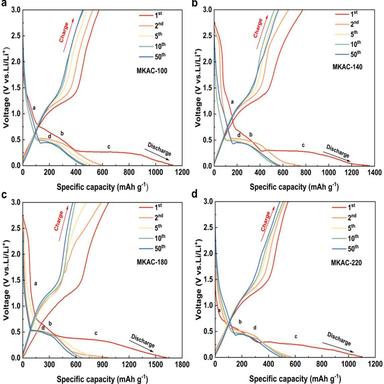
The first, second, fifth, tenth and fiftieth charge–discharge curves of the MKAC-T anodes prepared by four different solvothermal temperature: (a) MKAC-100, (b) MKAC-140, (c) MKAC-180, (d) MKAC-220.